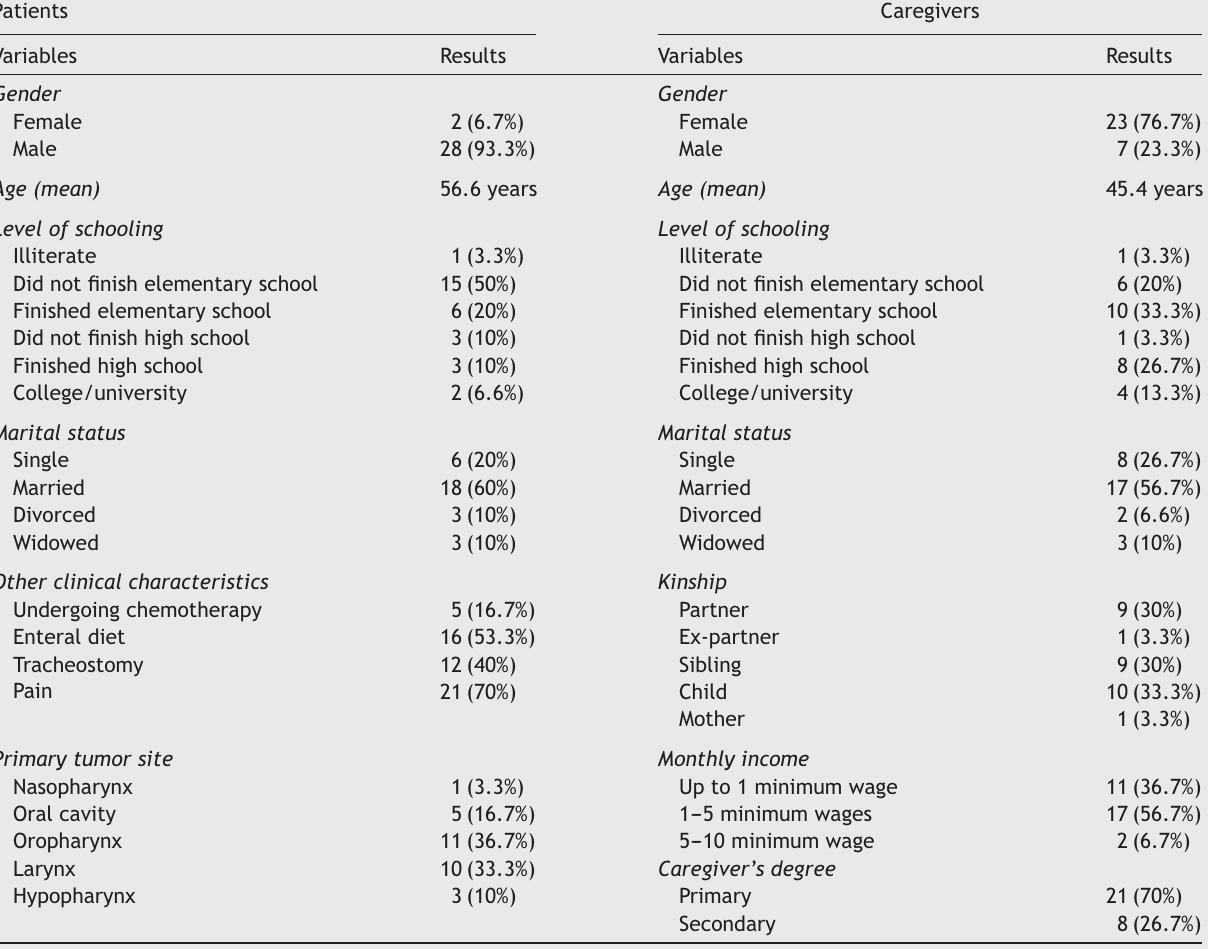
Table 1 Descriptive data of patients and their caregivers included in the study ( n = 30 in each group). Patients